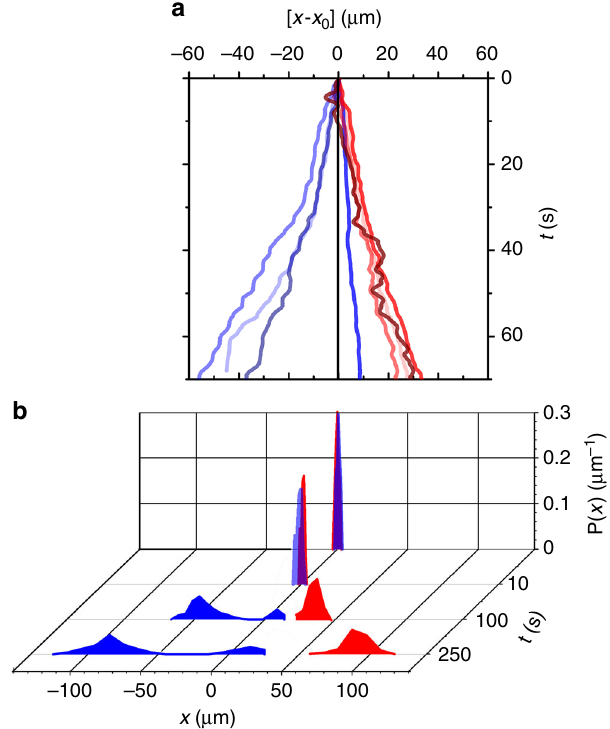
Fig. 5 Sorting of a binary suspension of APs by periodic trains of traveling pulses. a Experimental trajectories for different particle diameters σ = 3.25 μ m (blue) and 4.9 μ m (red) for u = 2 μ m/s, v max = 2 μ m/s, w = 4 σ and T = p 5 s. b The corresponding time evolution of the probability distribution P ( x ) of each active species σ = 3.25 μ m (blue) and 4.9 μ m (red). Data averaged over at least 30 trajectories